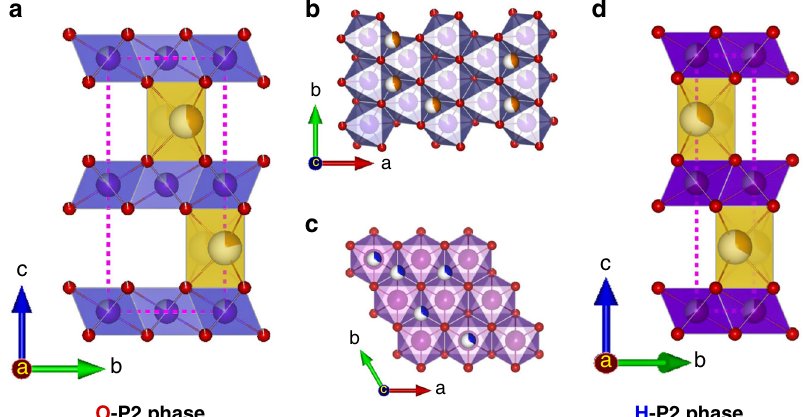
Fig. 1 Crystal structure of O-P2 phase and H-P2 phase. Schematic illustration of the orthorhombic P2 phase projected in ( a ) b – c plane, ( b ) a – b plane or along c -direction. And H-P2 phase in ( c ) a – b plane, and ( d ) b – c plane. Brown balls represent potassium, red balls oxygen, and blue balls transition metal atoms. Partially colored balls represent partial occupancy where the portion of white area represent the likelihood of the site's not having an